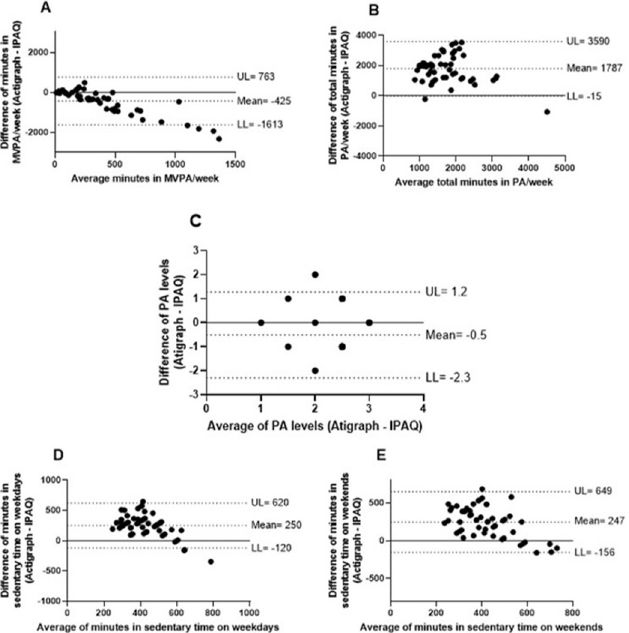
Fig 1. Bland-Altman plots for agreement between the International Physical Activity Questionnaire (IPAQ)-short form and measured physical activity (Actigraph) in the variables: moderate-to-vigorous physical activity (MVPA) per week (A); total minutes in PA per week (B); categorization in PA levels (C); minutes in sedentary time on weekdays (D) and on weekends (E).